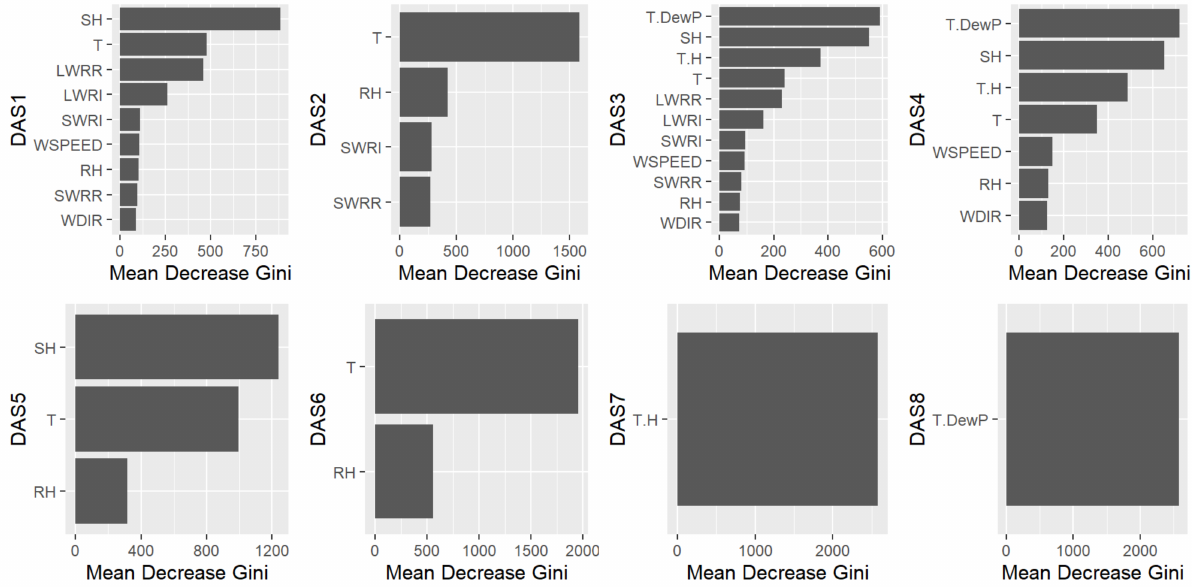
Figure 11. Identification of precipitation phase meteorological drivers (variables) using RF. The mean decrease Gini index is compared for this purpose for each DAS, DAS1 to DAS8, from left to right and from top to